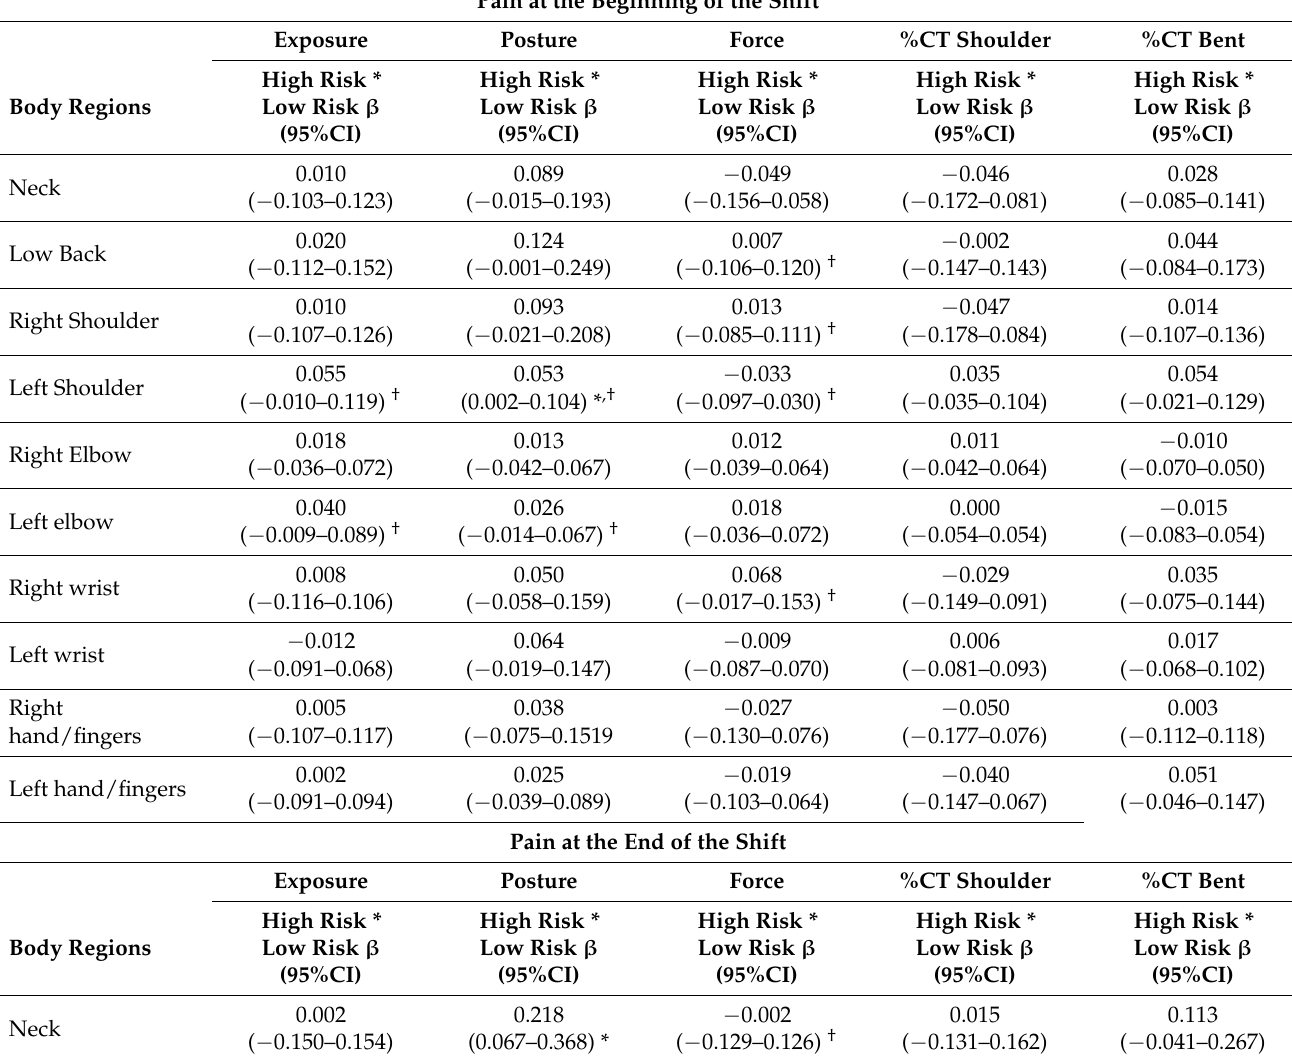
Table 2. Within and between-group changes in musculoskeletal symptoms in different body regions for different biome- chanical risk factors, after a workweek. Betas ( β ) are presented as unstandardized coefficients adjusted. The model is adjusted for gender, age, seniority, and baseline whenever differences were found between the low-risk and high-risk groups, with the respective 95% confidence